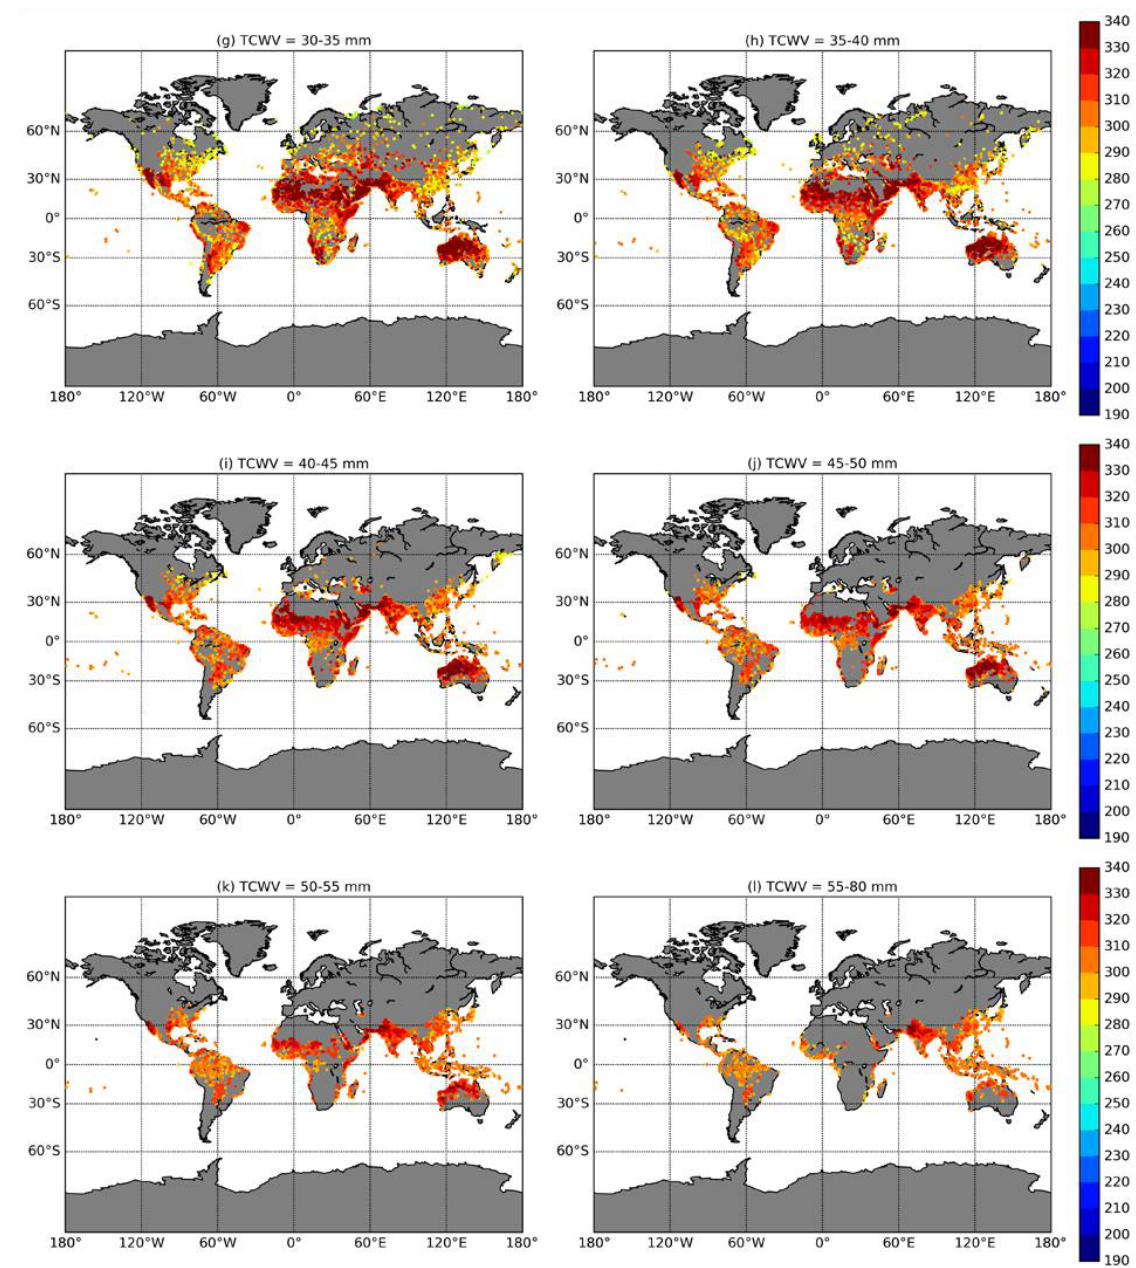
Figure 2. Geographical distribution of the profiles selected for the atmospheric general database for each class of TCWV (( a ) 0–5 mm; ( b ) 5–10 mm; ( c ) 10–15 mm; ( d ) 15–20 mm; ( e ) 20–25 mm; ( f ) 25–30 mm; ( g ) 30–35 mm; ( h ) 35–40 mm; ( i ) 40–45 mm; ( j ) 45–50 mm; ( k ) 50–55 mm; ( l ) 55–80 mm). Colors and respective colorbar indicate the corresponding class of Tskin